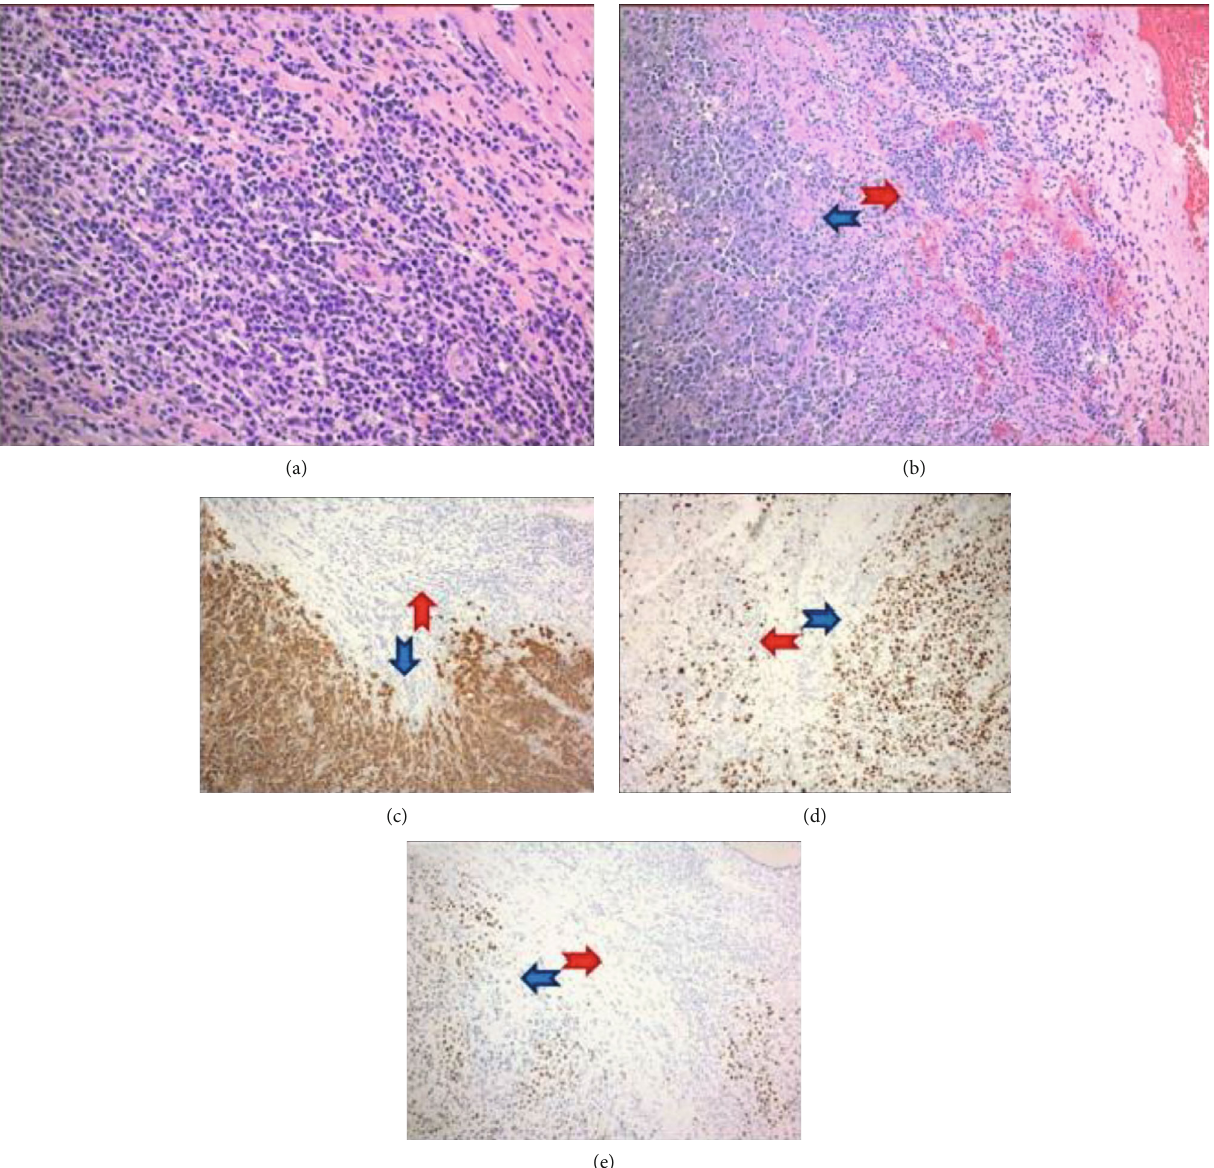
Figure 4: (a) The mature plasma cell population (H&E, 200x). (b) Interface of PBL (blue arrow) and mature plasma cell population (red arrow) (H&E, 100x). (c) – (e) Interface of PBL and mature plasma cell population showing opposite expression of EBER-ISH ((c), 40x), Ki- 67 ((d), 40x), and c-MYC ((e),